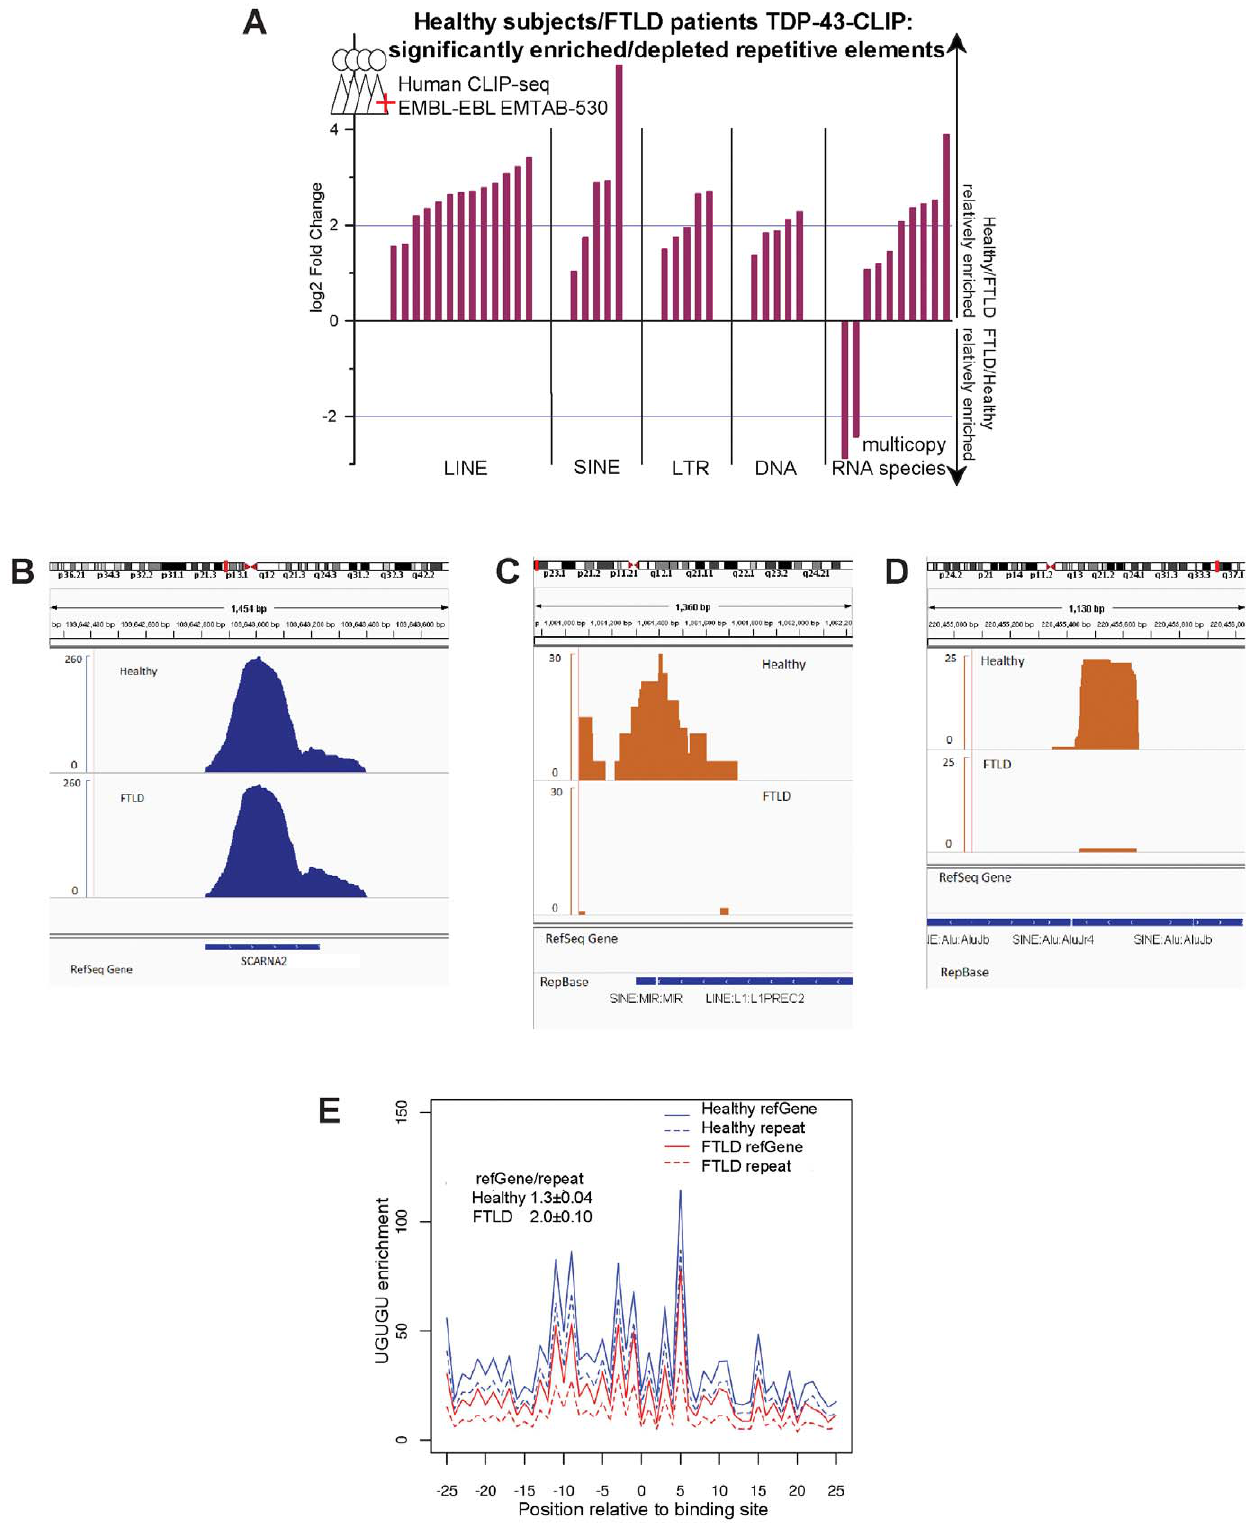
Figure 2. TDP-43 binding to TEs is selectively lost in FTLD patients. ( A ) In the human CLIP-seq data from FTLD versus healthy control, 38 repeat elements showed significant ( p -value , =1e-5 and fold changes . =2) differential binding. Log2 fold binding differences are shown for significantly enriched/depleted elements. ( B,C,D ) Peaks are shown in genome browser for one RefGene control ( B ) and two differentially targeted TEs ( C,D ) in Healthy ( top ) versus FTLD ( bottom ). ( E ) Enrichment for the UGUGU motif relative to its prevalence in the genome is shown across a 51- nt window surrounding binding sites ( 2 25 nt, 25 nt). Healthy samples ( Blue ) show similar enrichment for the UGUGU pentamer motif among